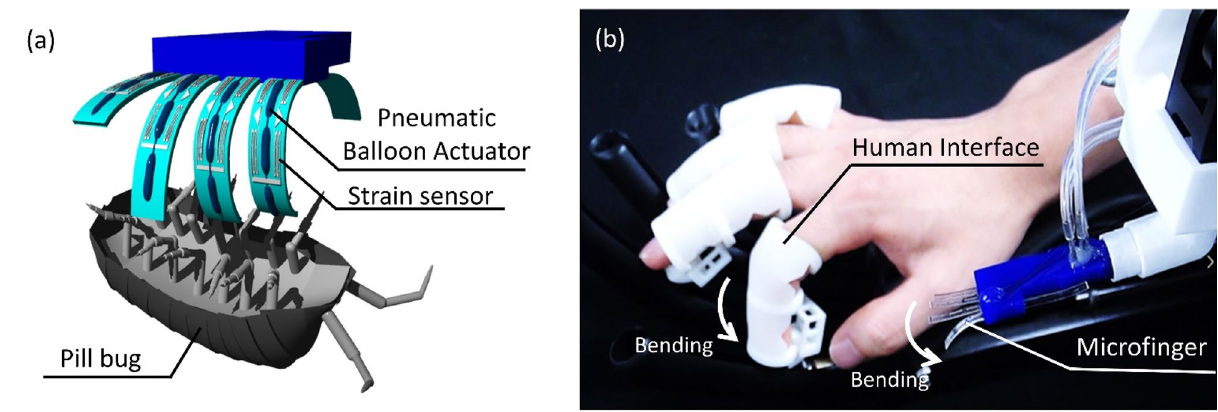
Figure 1. Microfinger-insect interaction. ( a ) Schematic drawing of microfinger-insect (pill bug) interaction. Shade3D Basic ver. 17.0.0 (https:// shade 3d. jp/ en/) was used to create the images. ( b ) Photograph of a developed microhand with five microfingers. This study focuses on a single microfinger, whereas the microhand in the photograph ( b ) implies the potential of human hand-insect interactions through the haptic teleoperation robot system 19,20